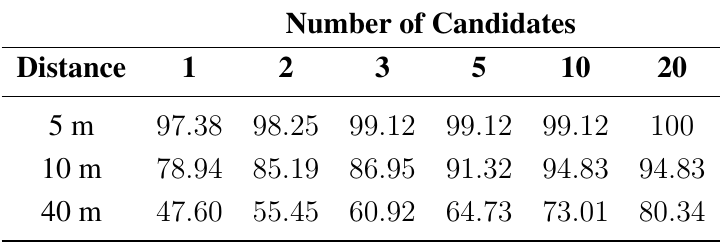
Table 3. Percentage of correct detections of order n of the mCHT-based detector. Number of Candidates